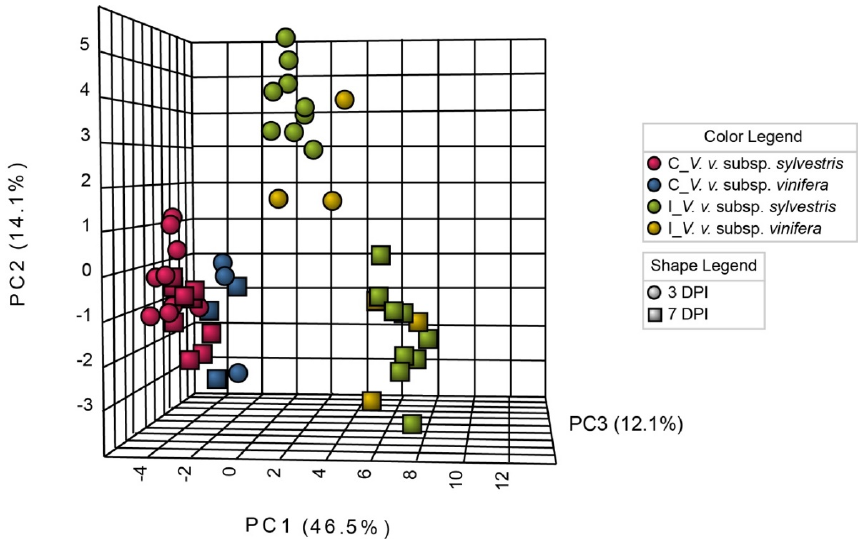
Figure 1. Three-dimensional principal component analysis (3D-PCA) of primary metabolite contents. PCA was performed on mean values at three and seven days post-infection (DPI) normalized to T0 non-inoculated control. Control samples (C) were mock-inoculated with potato dextrose agar (PDA), inoculated samples (I) were inoculated with N. parvum . Each time point is represented by a symbol (dots for three DPI and rectangles for seven DPI). The V. v. subsp. sylvestris and V. v. subsp. vinifera genotypes are represented by di ff erent colors (red for V. v. subsp. sylvestris and blue for V. v. subsp. vinifera for C samples and green for V. v. subsp. sylvestris and yellow for V. v. subsp. vinifera for I samples). The three major principal components explained 72.7% of the cumulative